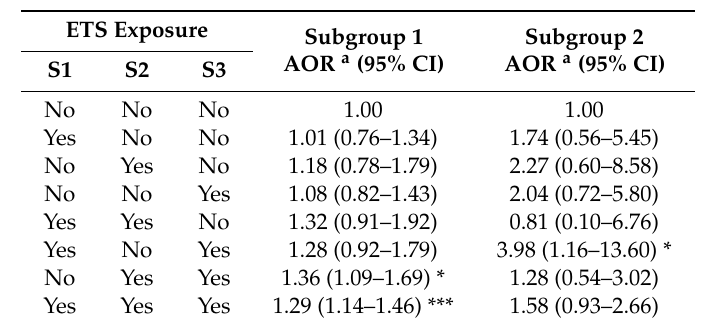
Table 4. Sensitivity analysis of association between astigmatism and combinations of pre- and post-natal ETS exposure among children with normal birth weight and low birth weight.